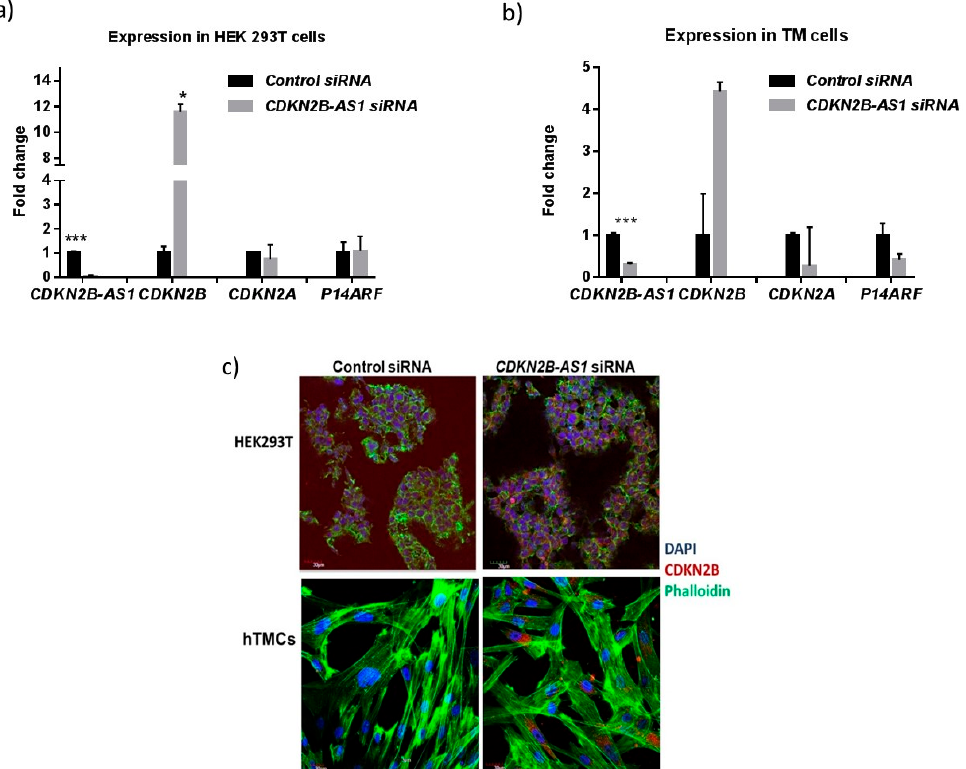
Figure 3. CDKN2B-AS1 siRNA mediated knockdown in HEK293T and trabecular meshwork (TM) cells. ( a , b ) Relative quantification of CDKN2B-AS1 , CDKN2B , CDKN2A and P14ARF transcript in HEK293T and TM cells after CDKN2B-AS1 siRNA (10 nm) treatment when compared to control siRNA (10 nm) treatment for 72 h; ( c ) Representative cultures established after CDKN2B-AS1 and control siRNA treatment demonstrated increased CDKN2B (red) detection in phalloidin (green) stained HEK293T and TM cells. (Scale bar represents 30 µ m; *** denotes p < 0.001; * denotes p < 0.01, Bar graphs illustrate fold change (2 −ΔΔ C T ) ± SEM).